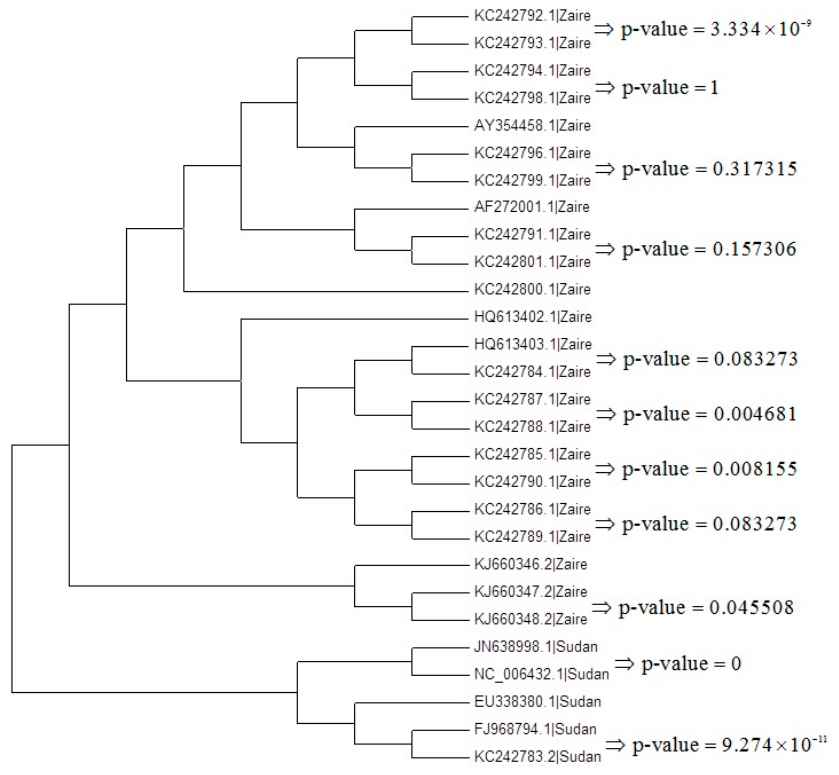
Figure 6. The p-values for testing the nucleotide substitution number between sequences in the first clades for the maximum likelihood tree based on the JC69 model.